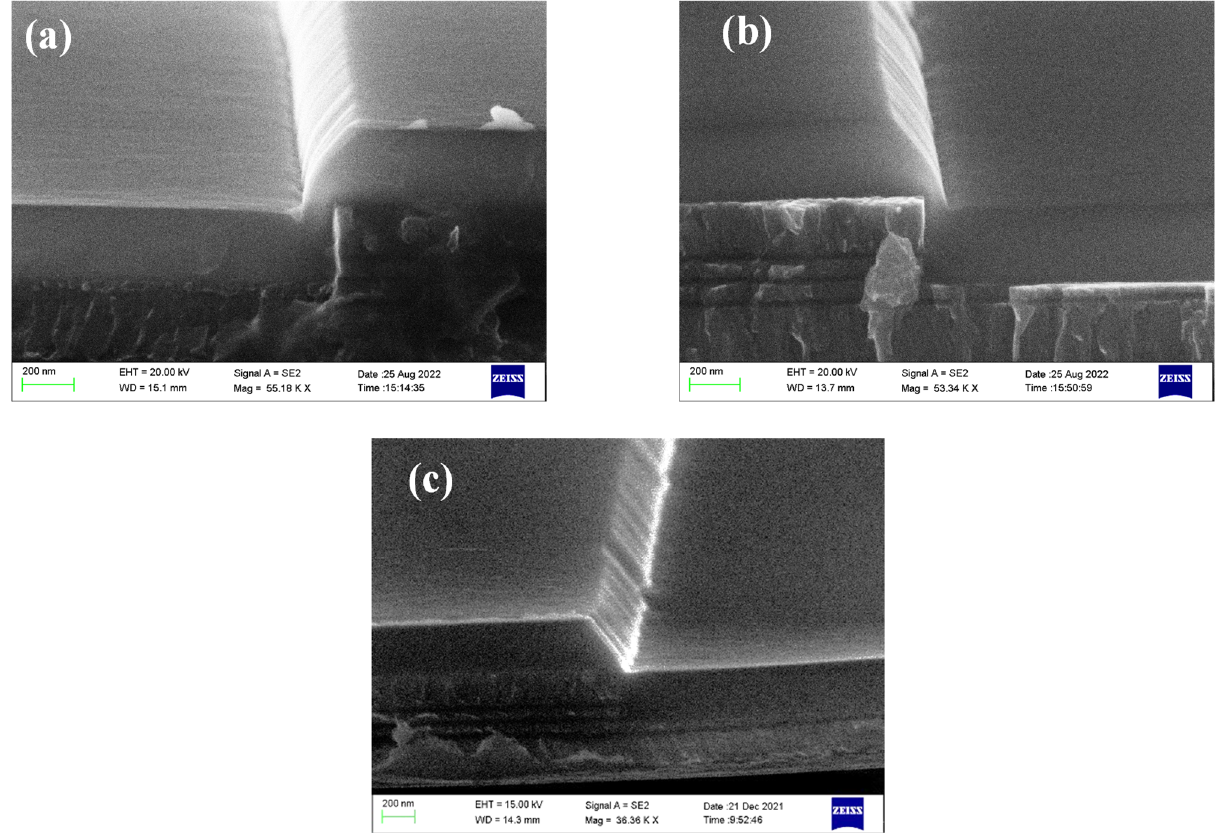
Figure 6. SEM images of the step coverage profile of the sample for deposition pressures of ( a ) 6 mTorr, ( b ) 5 mTorr, and ( c ) 4 mTorr. The RF power was set at 200 W, and the ICP power was set at 800 W.